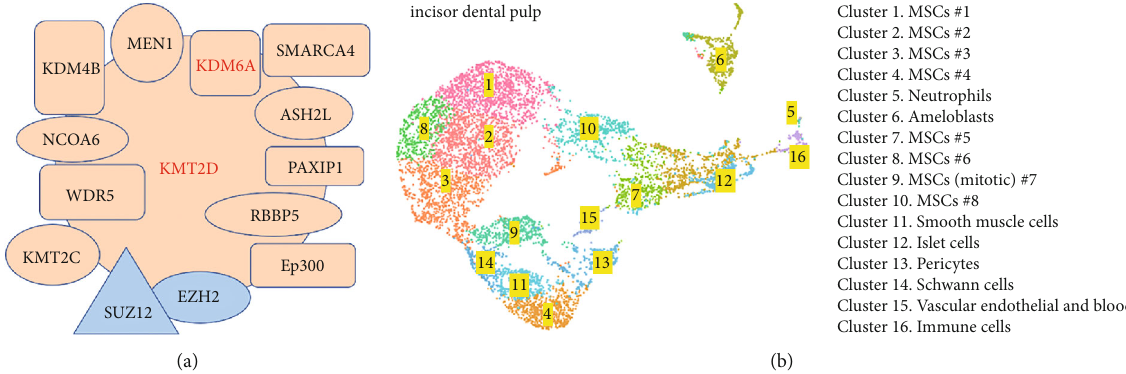
Figure 1: The interaction network of KMT2D and KDM6A and scRNA-seq clustering analysis of the mouse incisor dental pulp. (a) STRING interaction network analysis revealed that both KMT2D and KDM6A associate with other components of the SET1/COMPASS complex, including KMT2C, ASH2L, WDR5, RBBP5, KDM4B, p300, NCOA6, SMARCA4, PAXIP1, and MEN1. In addition, this analysis revealed that KMT2D and KDM6A physically interact with EZH2 and SUZ12, key components of the PRC2. (b) The mouse incisor dental pulp is composed of 16 distinct cell types that represent MSCs at di ff erent stages of osteogenic and odontogenic di ff erentiation as well as pericytes, ameloblasts, smooth muscle cells, islet cells, Schwann cells, vascular endothelial, and blood